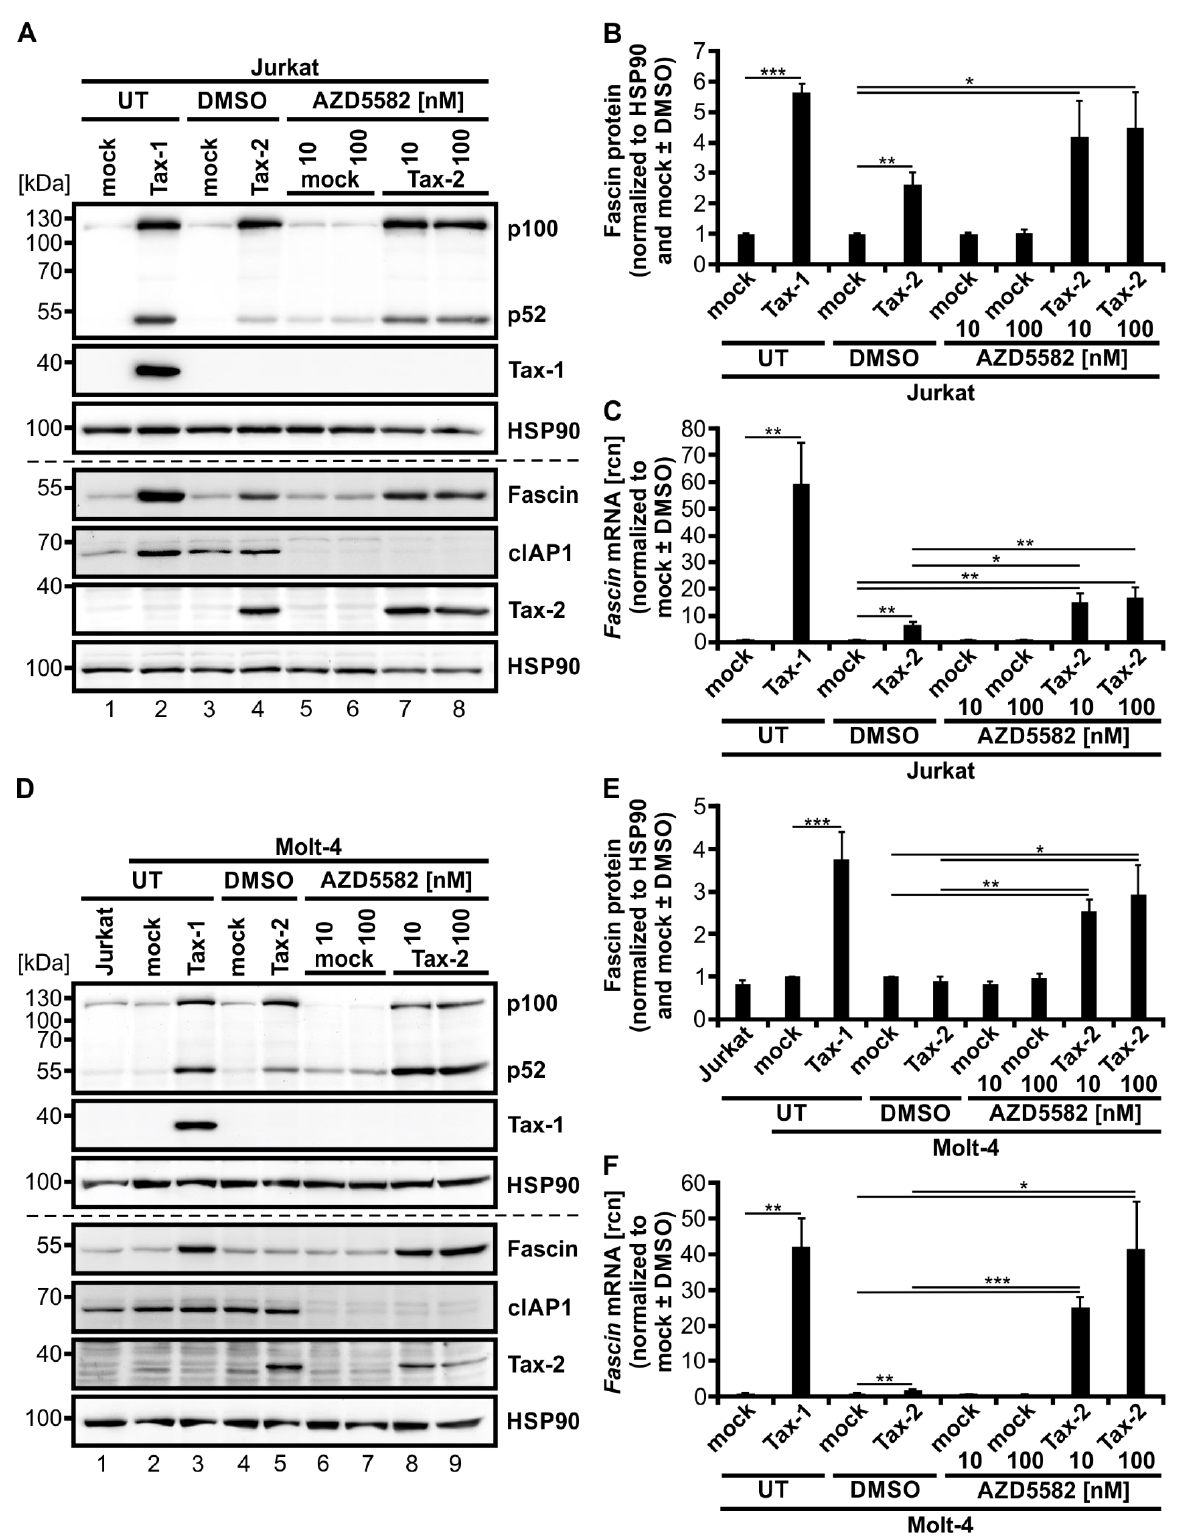
Figure 7. ActivationofbothclassicalandalternativeNF- κ